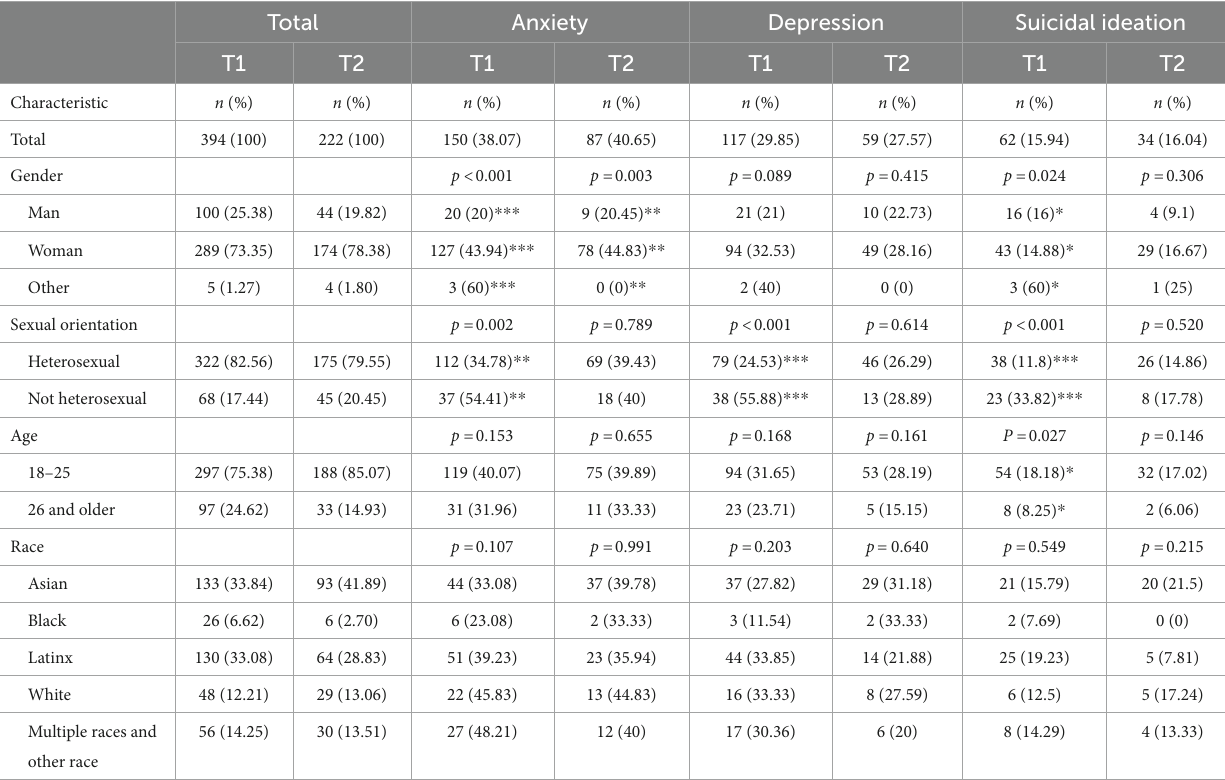
TABLE 1 Mental health status during COVID-19.